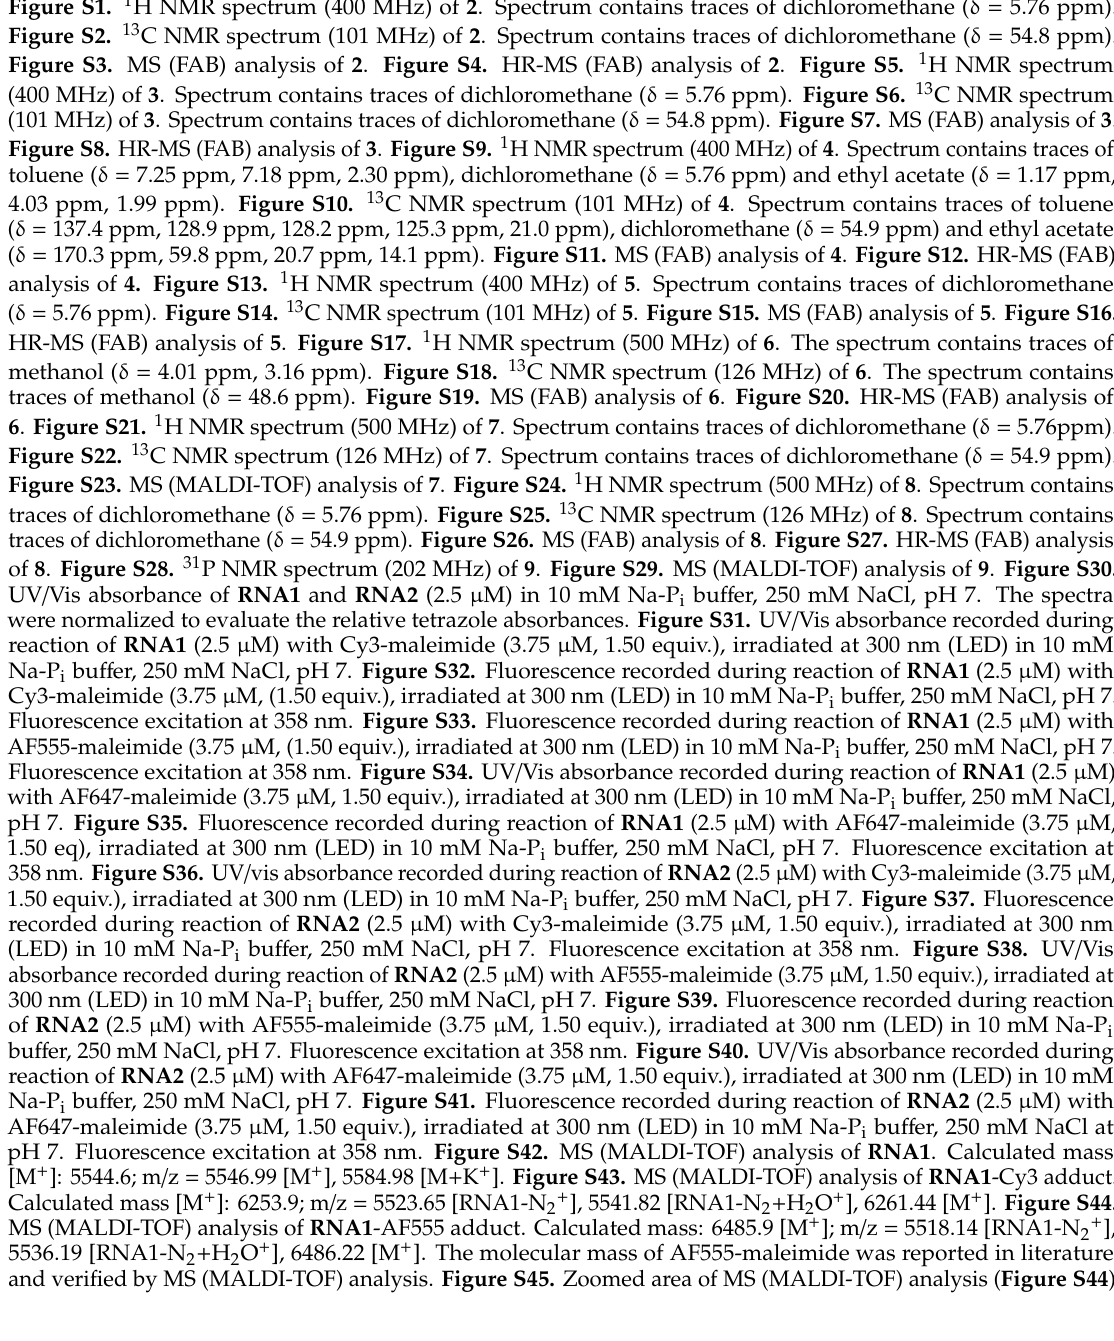
Figure S1. 1 H NMR spectrum (400 MHz) of 2 . Spectrum contains traces of dichloromethane ( δ = 5.76 ppm). Figure S2. 13 C NMR spectrum (101 MHz) of 2 . Spectrum contains traces of dichloromethane ( δ = 54.8 ppm). Figure S3. MS (FAB) analysis of 2 . Figure S4. HR-MS (FAB) analysis of 2 . Figure S5. 1 H NMR spectrum (400 MHz) of 3 . Spectrum contains traces of dichloromethane ( δ = 5.76 ppm). Figure S6. 13 C NMR spectrum (101 MHz) of 3 . Spectrum contains traces of dichloromethane ( δ = 54.8 ppm). Figure S7. MS (FAB) analysis of 3 . Figure S8. HR-MS (FAB) analysis of 3 . Figure S9. 1 H NMR spectrum (400 MHz) of 4 . Spectrum contains traces of toluene ( δ = 7.25 ppm, 7.18 ppm, 2.30 ppm), dichloromethane ( δ = 5.76 ppm) and ethyl acetate ( δ = 1.17 ppm, 4.03 ppm, 1.99 ppm). Figure S10. 13 C NMR spectrum (101 MHz) of 4 . Spectrum contains traces of toluene ( δ = 137.4 ppm, 128.9 ppm, 128.2 ppm, 125.3 ppm, 21.0 ppm), dichloromethane ( δ = 54.9 ppm) and ethyl acetate ( δ = 170.3 ppm, 59.8 ppm, 20.7 ppm, 14.1 ppm). Figure S11. MS (FAB) analysis of 4 . Figure S12. HR-MS (FAB) analysis of 4. Figure S13. 1 H NMR spectrum (400 MHz) of 5 . Spectrum contains traces of dichloromethane ( δ = 5.76 ppm). Figure S14. 13 C NMR spectrum (101 MHz) of 5 . Figure S15. MS (FAB) analysis of 5 . Figure S16. HR-MS (FAB) analysis of 5 . Figure S17. 1 H NMR spectrum (500 MHz) of 6 . The spectrum contains traces of methanol ( δ = 4.01 ppm, 3.16 ppm). Figure S18. 13 C NMR spectrum (126 MHz) of 6 . The spectrum contains traces of methanol ( δ = 48.6 ppm). Figure S19. MS (FAB) analysis of 6 . Figure S20. HR-MS (FAB) analysis of 6 . Figure S21. 1 H NMR spectrum (500 MHz) of 7 . Spectrum contains traces of dichloromethane ( δ = 5.76ppm). Figure S22. 13 C NMR spectrum (126 MHz) of 7 . Spectrum contains traces of dichloromethane ( δ = 54.9 ppm). Figure S23. MS (MALDI-TOF) analysis of 7 . Figure S24. 1 H NMR spectrum (500 MHz) of 8 . Spectrum contains traces of dichloromethane ( δ = 5.76 ppm). Figure S25. 13 C NMR spectrum (126 MHz) of 8 . Spectrum contains traces of dichloromethane ( δ = 54.9 ppm). Figure S26. MS (FAB) analysis of 8 . Figure S27. HR-MS (FAB) analysis of 8 . Figure S28. 31 P NMR spectrum (202 MHz) of 9 . Figure S29. MS (MALDI-TOF) analysis of 9 . Figure S30. UV / Vis absorbance of RNA1 and RNA2 (2.5 µ M) in 10 mM Na-P i bu ff er, 250 mM NaCl, pH 7. The spectra were normalized to evaluate the relative tetrazole absorbances. Figure S31. UV / Vis absorbance recorded during reaction of RNA1 (2.5 µ M) with Cy3-maleimide (3.75 µ M, 1.50 equiv.), irradiated at 300 nm (LED) in 10 mM Na-P i bu ff er, 250 mM NaCl, pH 7. Figure S32. Fluorescence recorded during reaction of RNA1 (2.5 µ M) with Cy3-maleimide (3.75 µ M, (1.50 equiv.), irradiated at 300 nm (LED) in 10 mM Na-P i bu ff er, 250 mM NaCl, pH 7. Fluorescence excitation at 358 nm. Figure S33. Fluorescence recorded during reaction of RNA1 (2.5 µ M) with AF555-maleimide (3.75 µ M, (1.50 equiv.), irradiated at 300 nm (LED) in 10 mM Na-P i bu ff er, 250 mM NaCl, pH 7. Fluorescence excitation at 358 nm. Figure S34. UV / Vis absorbance recorded during reaction of RNA1 (2.5 µ M) with AF647-maleimide (3.75 µ M, 1.50 equiv.), irradiated at 300 nm (LED) in 10 mM Na-P i bu ff er, 250 mM NaCl, pH 7. Figure S35. Fluorescence recorded during reaction of RNA1 (2.5 µ M) with AF647-maleimide (3.75 µ M, 1.50 eq), irradiated at 300 nm (LED) in 10 mM Na-P i bu ff er, 250 mM NaCl, pH 7. Fluorescence excitation at 358 nm. Figure S36. UV / vis absorbance recorded during reaction of RNA2 (2.5 µ M) with Cy3-maleimide (3.75 µ M, 1.50 equiv.), irradiated at 300 nm (LED) in 10 mM Na-P i bu ff er, 250 mM NaCl, pH 7. Figure S37. Fluorescence recorded during reaction of RNA2 (2.5 µ M) with Cy3-maleimide (3.75 µ M, 1.50 equiv.), irradiated at 300 nm (LED) in 10 mM Na-P i bu ff er, 250 mM NaCl, pH 7. Fluorescence excitation at 358 nm. Figure S38. UV / Vis absorbance recorded during reaction of RNA2 (2.5 µ M) with AF555-maleimide (3.75 µ M, 1.50 equiv.), irradiated at 300 nm (LED) in 10 mM Na-P i bu ff er, 250 mM NaCl, pH 7. Figure S39. Fluorescence recorded during reaction of RNA2 (2.5 µ M) with AF555-maleimide (3.75 µ M, 1.50 equiv.), irradiated at 300 nm (LED) in 10 mM Na-P i bu ff er, 250 mM NaCl, pH 7. Fluorescence excitation at 358 nm. Figure S40. UV / Vis absorbance recorded during reaction of RNA2 (2.5 µ M) with AF647-maleimide (3.75 µ M, 1.50 equiv.), irradiated at 300 nm (LED) in 10 mM Na-P i bu ff er, 250 mM NaCl, pH 7. Figure S41. Fluorescence recorded during reaction of RNA2 (2.5 µ M) with AF647-maleimide (3.75 µ M, 1.50 equiv.), irradiated at 300 nm (LED) in 10 mM Na-P i bu ff er, 250 mM NaCl at pH 7. Fluorescence excitation at 358 nm. Figure S42. MS (MALDI-TOF) analysis of RNA1 . Calculated mass [M + ]: 5544.6; m / z = 5546.99 [M + ], 5584.98 [M + K + ]. Figure S43. MS (MALDI-TOF) analysis of RNA1 -Cy3 adduct. Calculated mass [M + ]: 6253.9; m / z = 5523.65 [RNA1-N 2 + ], 5541.82 [RNA1-N 2 + H 2 O + ], 6261.44 [M + ]. Figure S44. MS (MALDI-TOF) analysis of RNA1 -AF555 adduct. Calculated mass: 6485.9 [M + ]; m / z = 5518.14 [RNA1-N 2 + ], 5536.19 [RNA1-N 2 + H 2 O + ], 6486.22 [M + ]. The molecular mass of AF555-maleimide was reported in literature and verified by MS (MALDI-TOF) analysis. Figure S45. Zoomed area of MS (MALDI-TOF) analysis ( Figure S44